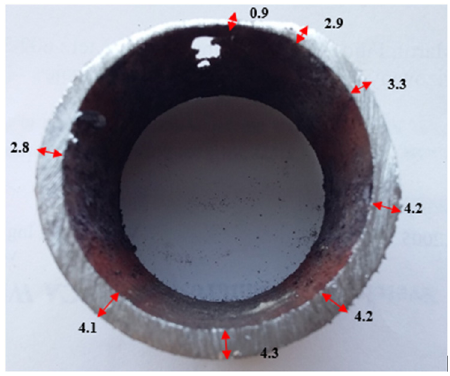
Figure 8. The wall thickness of the evaporator tube at the perforation area; wall thickness (in mm).